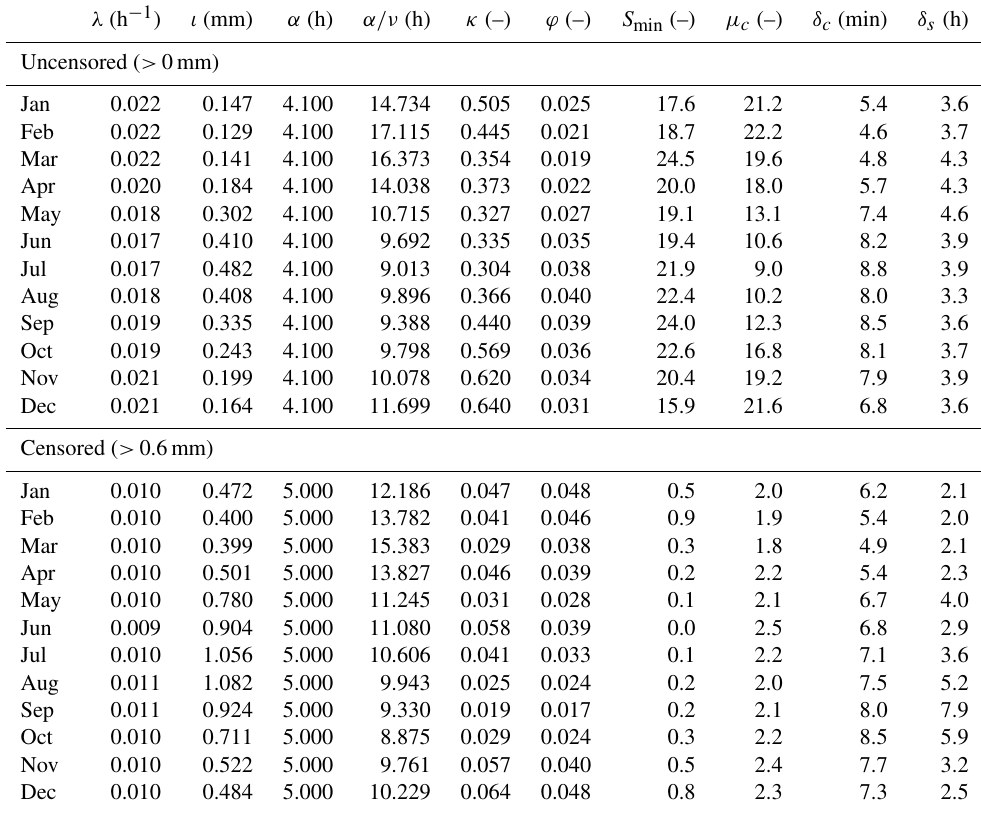
Table B4. BL1M model parameters for the Atherstone 15min